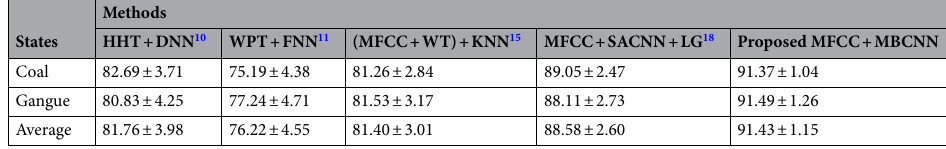
Table 4. F1-score (%) comparison with different methods on simulated site dataset.